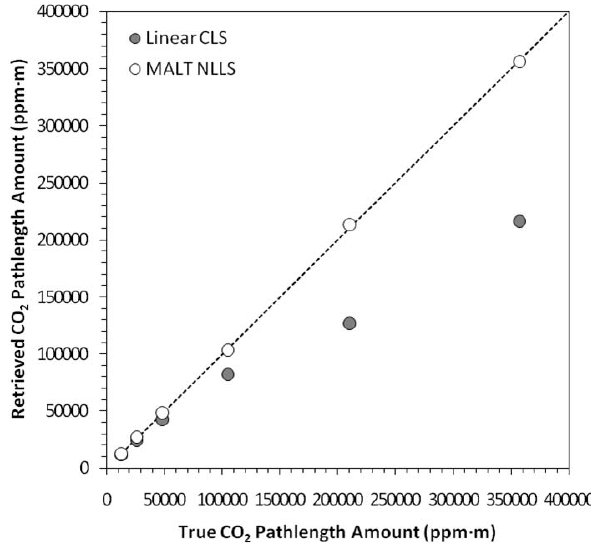
Fig. 1. Comparison of FTIR-derived retrievals of gas-cell CO 2 pathlength amount to the true pathlength amount within the cell. Retrievals were made from the same spectra via two approaches, the Classical Least Squares (CLS) approach described in Haa- land (1990) and the MALT forward model and nonlinear least squares (NLLS) fitting procedure described in Griffith (1996) and Griffith et al. (2003). The 1:1 line is shown, and the increasing underestimation of the CLS-based retrievals at higher pathlength amounts is clearly